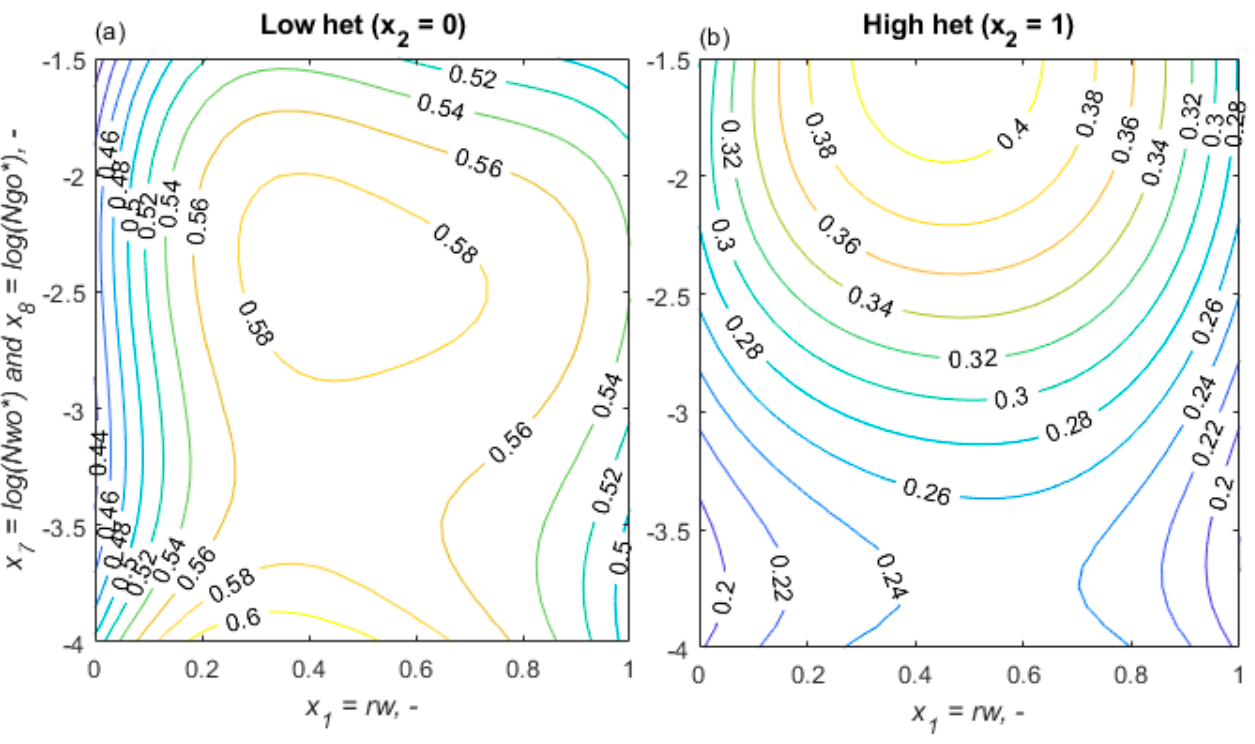
Figure 11. Contour plot of recovery factor RF plotted against x 1 = r w and log gravity number with equal values of x 7 and x 8 . Low-heterogeneity ( a ) and high-heterogeneity ( b ) cases are shown (see all input values in Table 6).